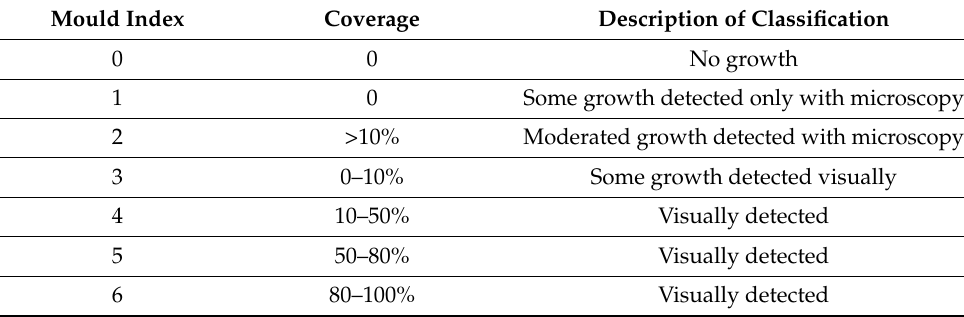
Table 2. Mould indexing classifications (adapted from